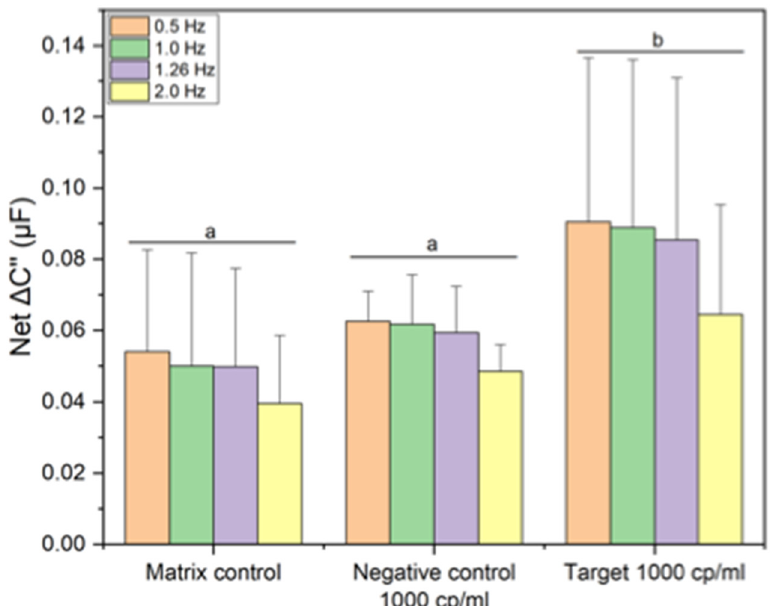
Figure 11. Representative capacitance response of ACE2-based biosensor for matrix effects (saliva target-free), negative control (common cold virus at 1000 copies/mL), and target (SARS-CoV-2 DELTA at 1000 copies/mL). Error bars represent standard deviation from the mean measurement (n = 3). Same letters represent groups with no significant difference ( p < 0.05). Table 2. Advantages and limitations of optical and electrochemical biosensors.